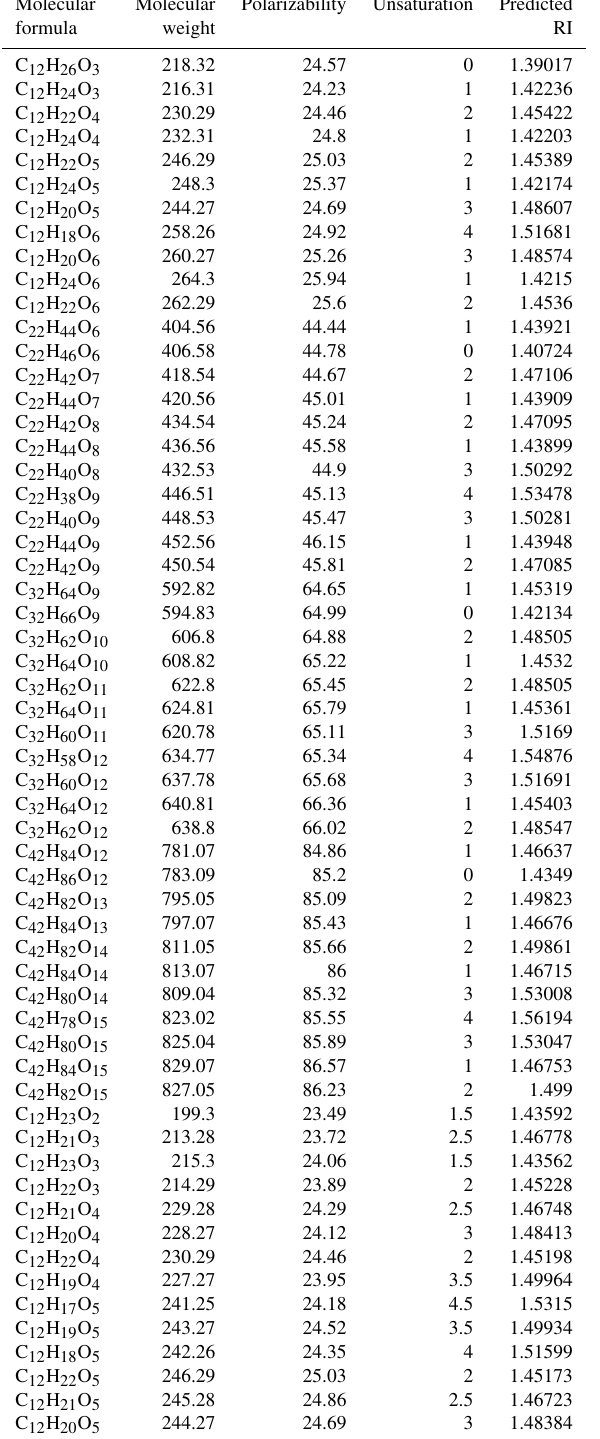
Table 2. The calculated RI values for the surrogate system: oligomers (11 types of PHA) and furan derivatives.